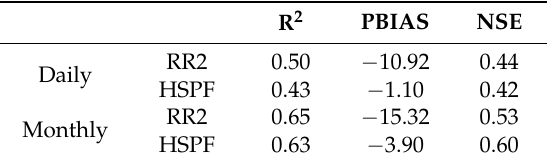
Table 14. Comparing the RR2 and HSPF models (verification period).